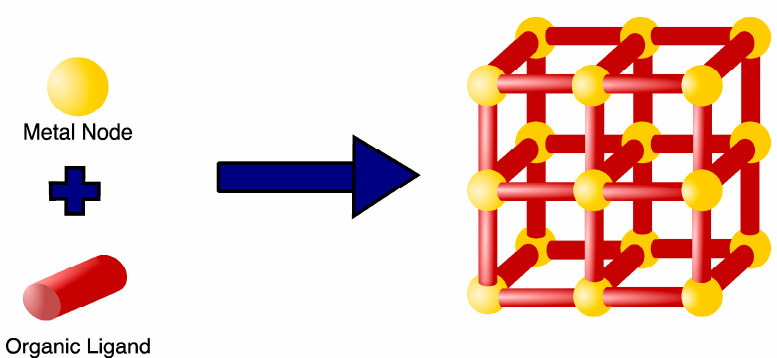
Figure 2. Example of a basic MOF structure. MOFs are highly organized porous nanomaterials composed of metal nodes coordinated with several organic ligands serving as a bridge between nodes.